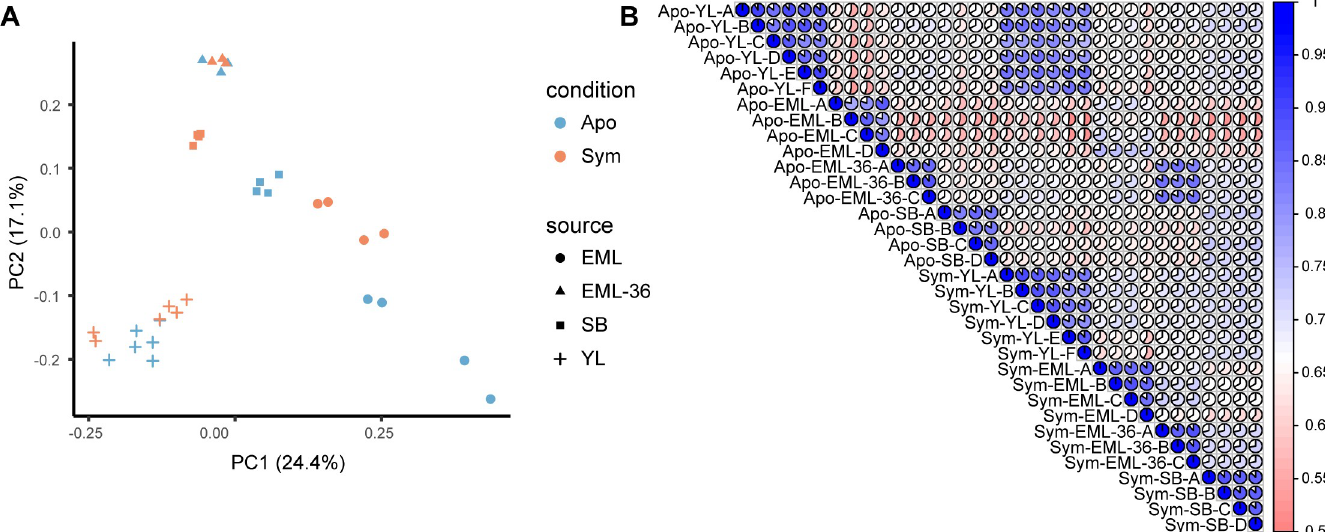
Fig 1. Relationship between samples from different studies. (A) Principal component analysis of samples across all four studies. The symbiotic state (condition) of the animals was indicated by the color of the points, while the source studies were represented as different shapes. (B) Kendall rank correlation of all samples, with high- correlation as blue, and low-correlation as red. The pie chart in each cell also indicates the correlation of the two samples from the corresponding row and column. In both figures, Apo and Sym represent the symbiotic state of the anemones: aposymbiotic and symbiotic, respectively.